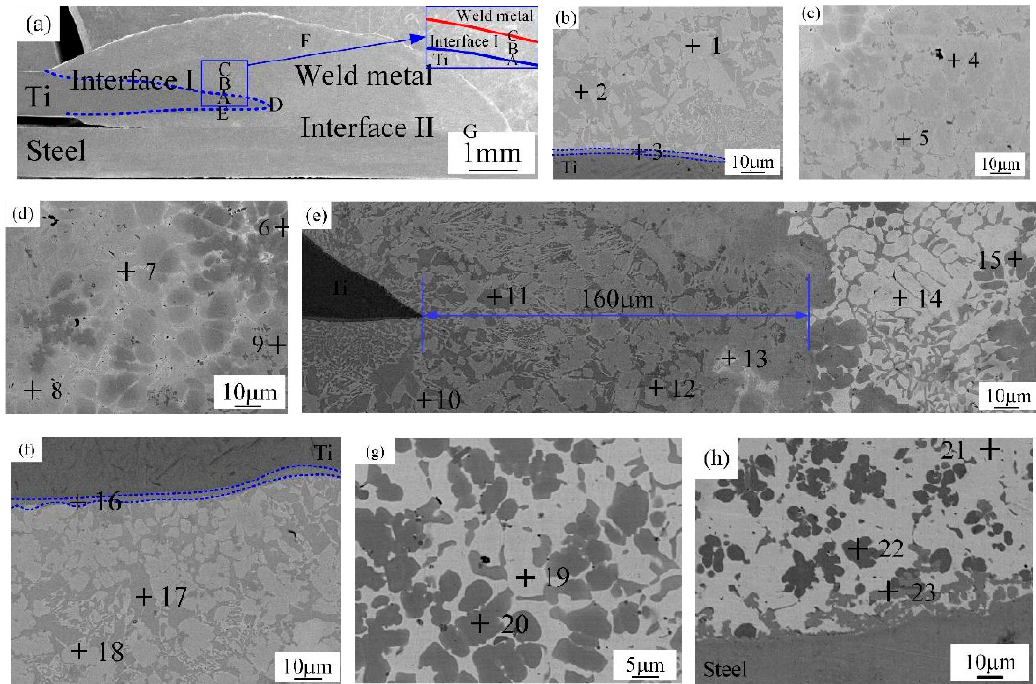
Figure 5. The microstructure of Joint I (sample #1); ( a ) the cross section sample, ( b ) magnified zone A in Figure 5a, ( c ) magnified zone B in Figure 5a, ( d ) magnified zone C in Figure 5a, ( e ) magnified zone D in Figure 5a, ( f ) magnified zone E in Figure 5a, ( g ) magnified zone F in Figure 5a and ( h ) magnified zone G in Figure 5a. Table 4. EDS analysis results of various zones for Joint I (specimen #1) in Figure 5 (at. %). Point.